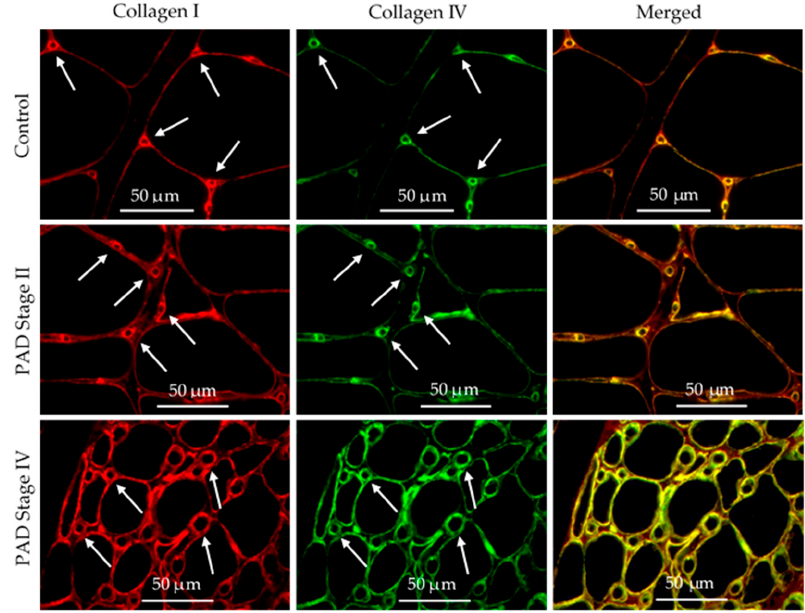
Figure 8. Co-localization of Collagen I and IV deposited as distinctive rings associated with micro-vessels in the calf muscle of control subjects and patients with PAD. Biopsy specimens embedded in paraffin were sectioned at four microns and mounted to glass slides. Slide specimens were labeled simultaneously with anti-Collagen I and anti-Collagen IV antibodies, and subsequently, with goat anti-rabbit and goat anti-mouse secondary antibodies (respectively) coupled with fluorophores. Images of each slide specimen were taken in separate fluorescence channels corresponding to each collagen label, with a widefield microscope (40× objective). Distinctive rings of Collagen I ( Red ) and Collagen IV ( Green ) delineate micro-vessels ( Arrows ) and are co-localized ( Yellow ) in the basement membrane. Myofibers are identified as large black areas delineated by both Collagen I and Collagen IV. Labeling of inter-myofiber Collagen I ( Red ) is readily apparent in the merged images of the Stage II and Stage IV specimens. Scale bars represent 50 microns.